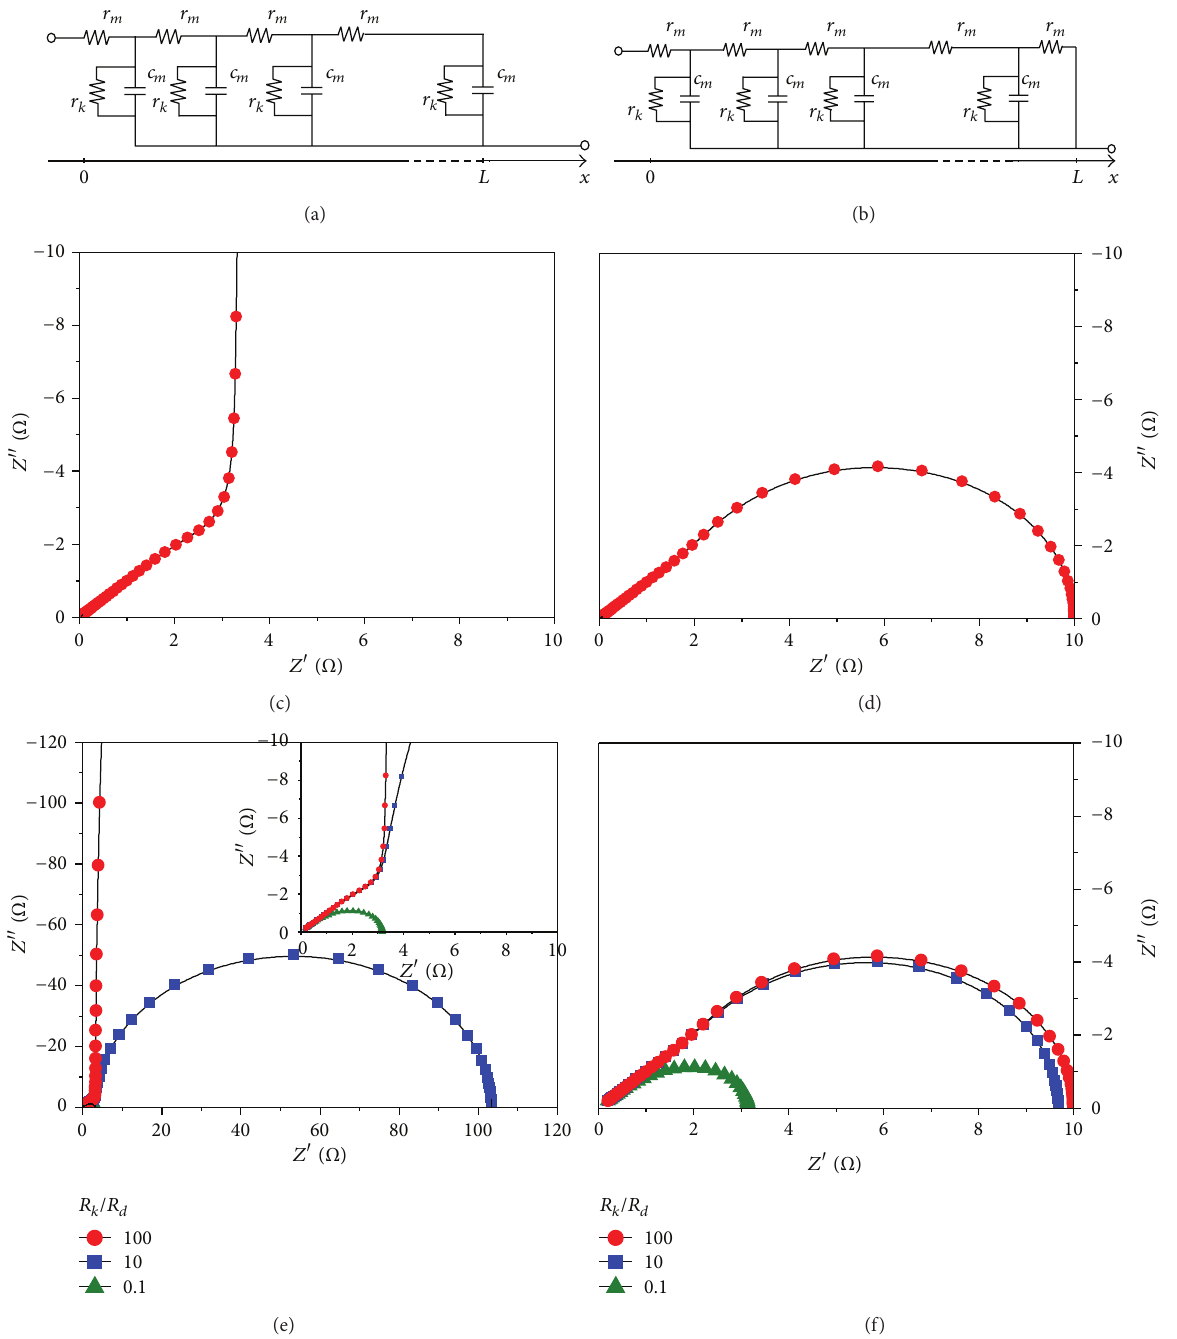
Figure 8: Finite-length transmission line models of diffusion-reaction impedance with (a) reflective and (b) absorbing boundary condition. Complex plane plots of the impedance model for diffusion with the (c) reflective boundary condition and (d) the absorbing boundary condition. Complex plane plot of the impedance model for diffusion coupled with a homogeneous reaction with the (e) reflective boundary condition (inset shows magnified view of the high frequency region of the plot) and (f) the absorbing boundary